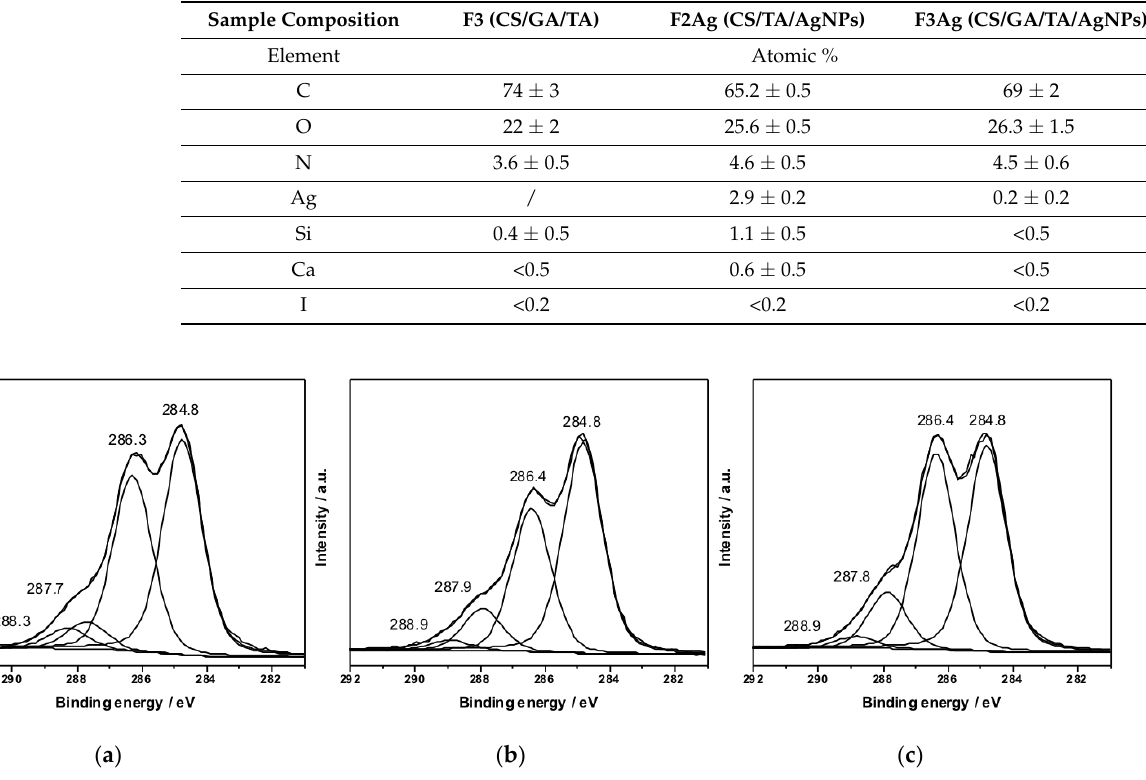
Figure 9. C1s XP deconvoluted spectra relevant to: ( a ) F3 (CS/GA/TA), ( b ) F2Ag (CS/TA/AgNPs), and ( c ) F3Ag (CS/GA/TA/AgNPs) films. Table 4. C1s components identified for F3, F2Ag, and F3Ag samples. The maximum error on the peak position is ± 0.2